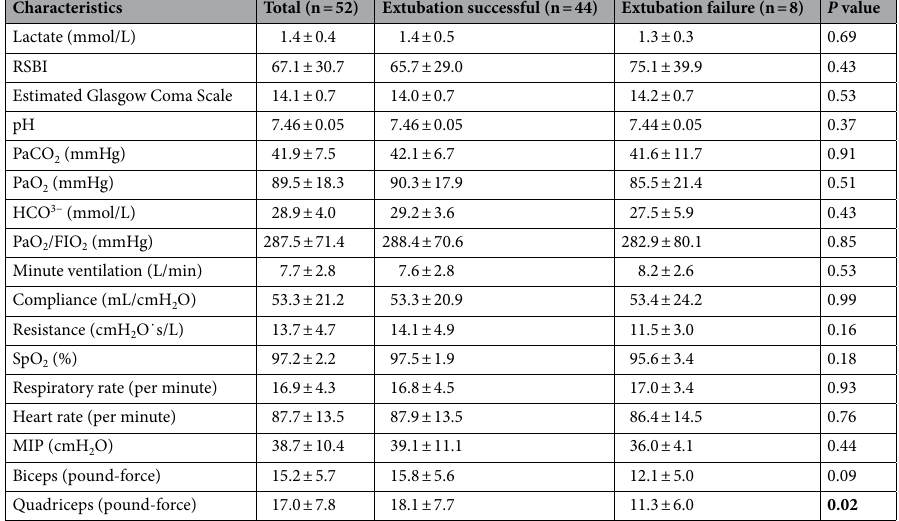
Table 2. Patient characteristics at time before planned extubation. RSBI rapid shallow breathing index, MIP maximum inspiratory pressure. Bold values are statistically significant.